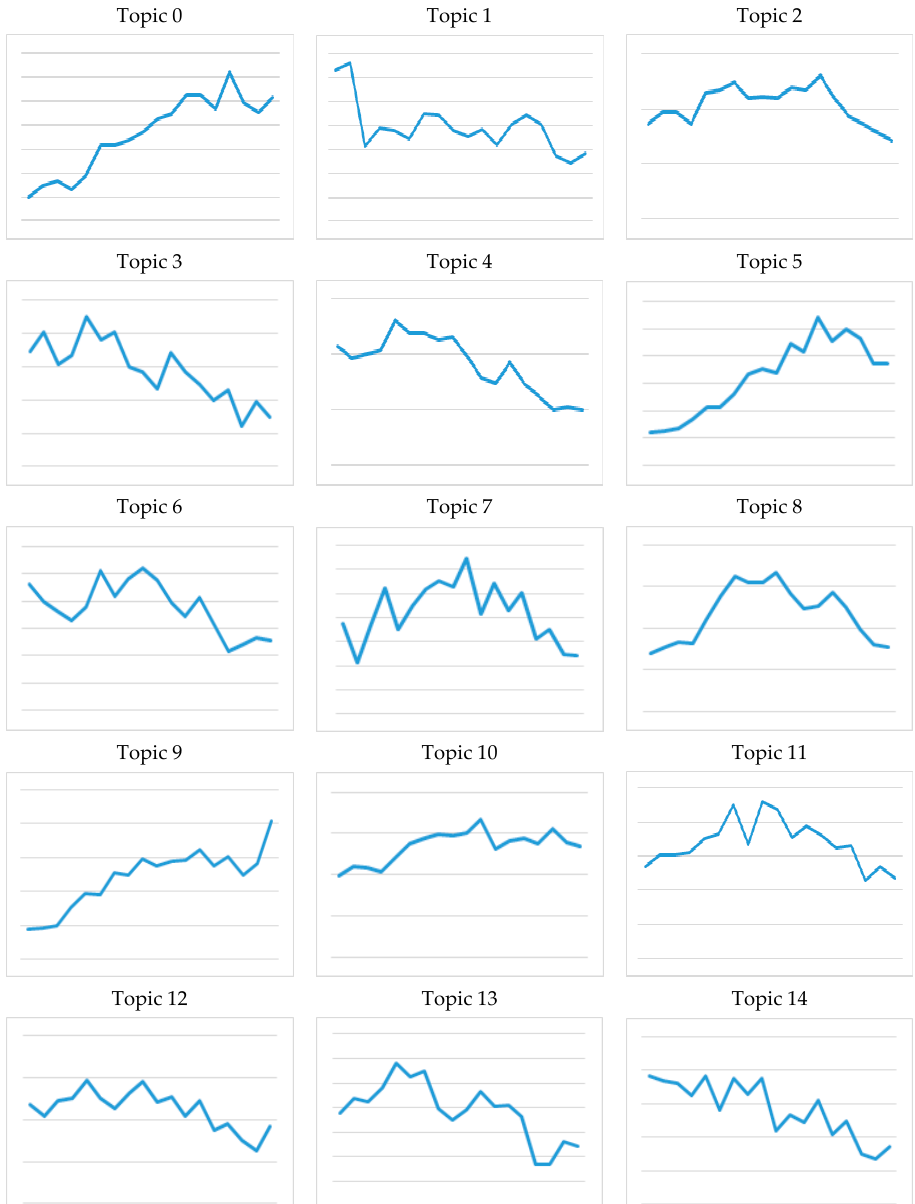
Figure 5. Trends in research topics by year.